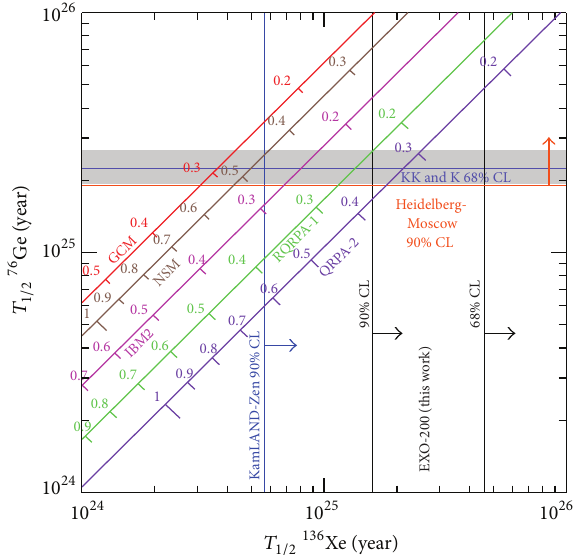
Figure 5: This figure compares the expected half-lives of 136 Xe and 76 Ge for matrix elements from various models. References for the models are found in the